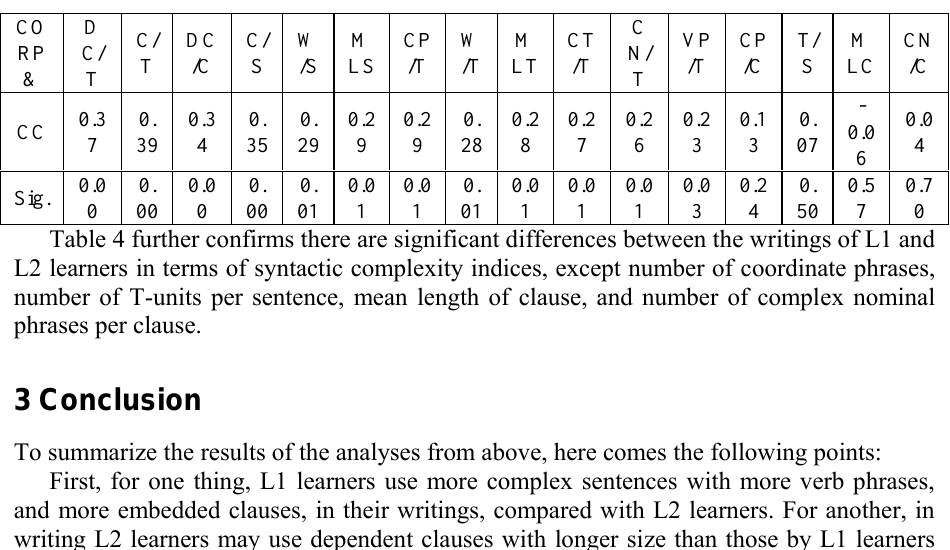
Table 4. T-test, paired sample correlation